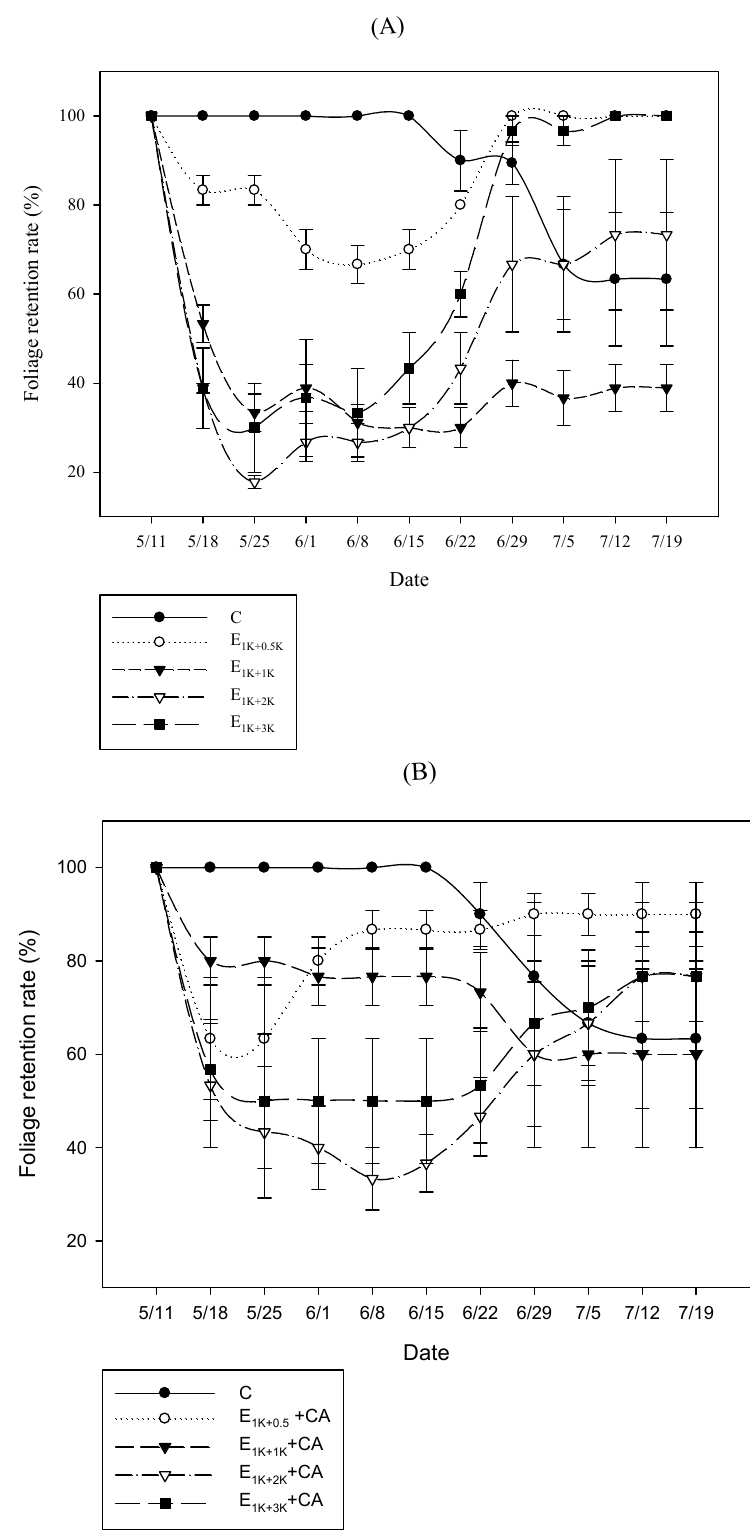
Figure 4. Foliage retention rate movement of golden shower trees between 11 May and 19 July under ethephon and ethephon + CA treatments. The control plants defoliated after 15 June due to summer stress. ( A ) Pure ethephon treatments. ( B ) Ethephon + CA